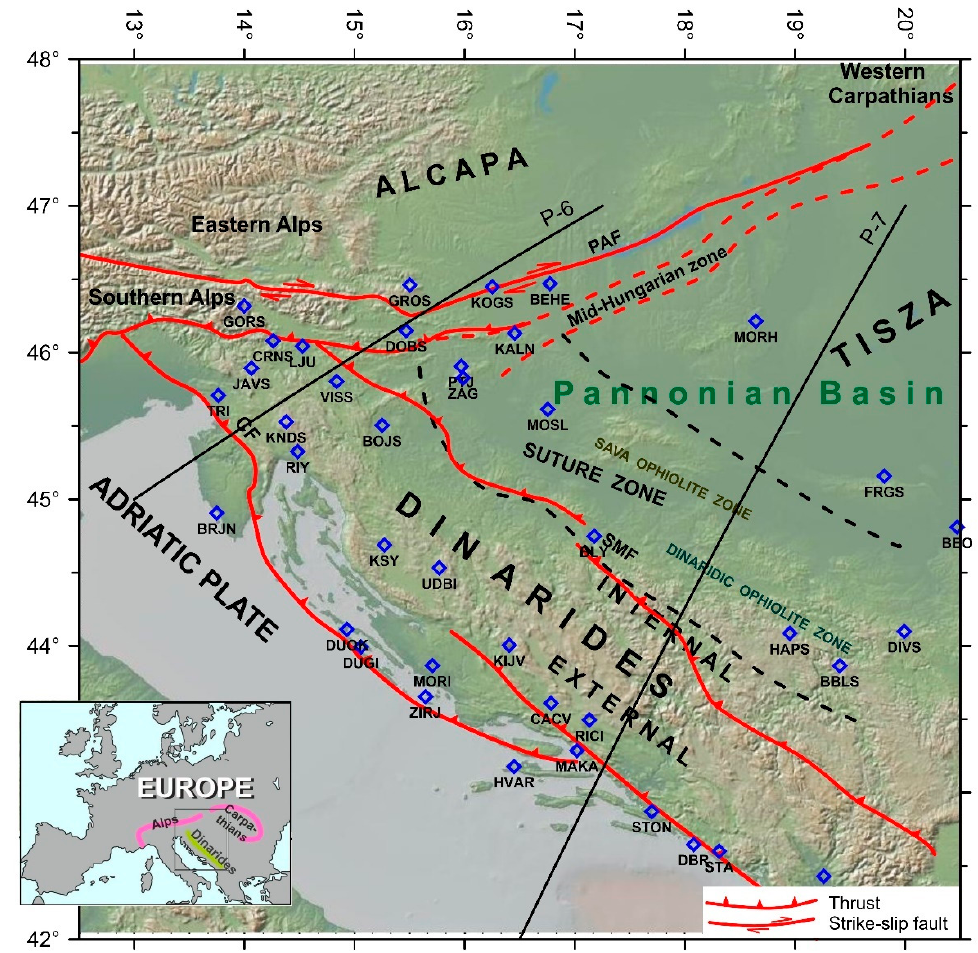
Figure 1. Topographic and position map with tectonics of the Pannonian–Dinaridic including the border area of the Alcapa (Alpine–Carpathian tectonic unit). Permanent seismic stations in the survey area are shown as blue diamonds and the seismic profiles P-6 and P-7 as black lines [8]. The main tectonic units and faults are superimposed on the topographic map (PAF—Periadriatic fault, CF— Ć i ć arija fault, SMF—South marginal fault of the Pannonian Basin). The borders of the suture zone after [15].